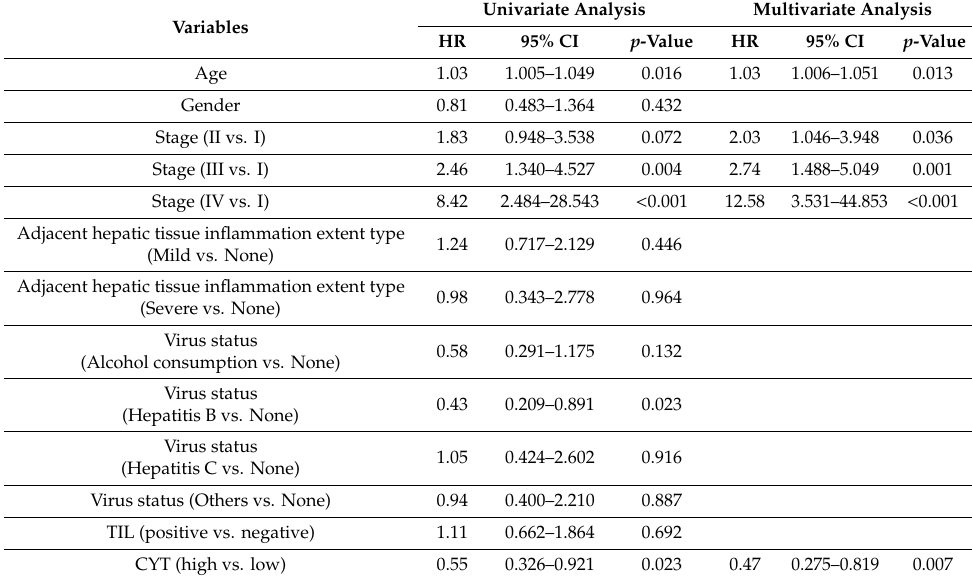
Table 3. Univariate and multivariate analysis for the